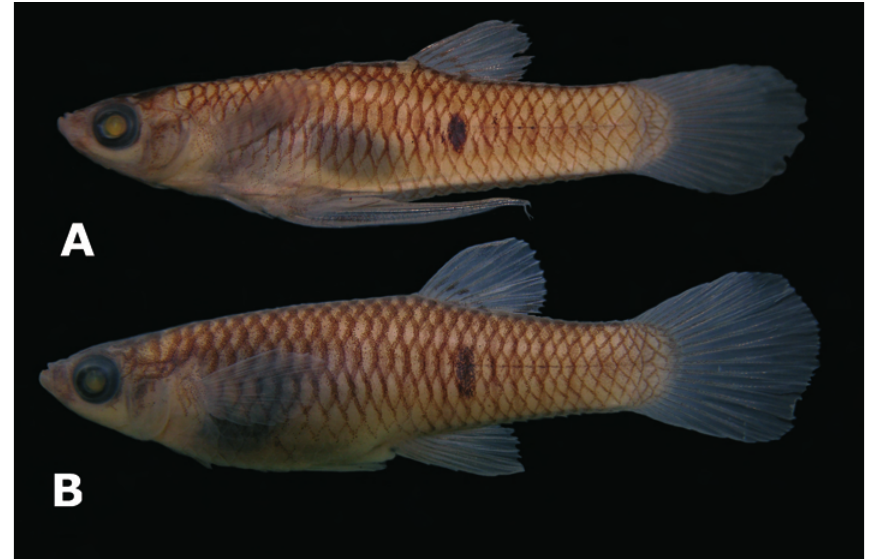
Fig. 46. Phalloceros pellos . (A) Holotype, male, 26.4 mm SL, MCP 31142, Antonina, lateral pond on road near rio Nunes, Paraná, Brazil; (B) paratype, female, MCP 31141, 29.9 mm SL, collected with the